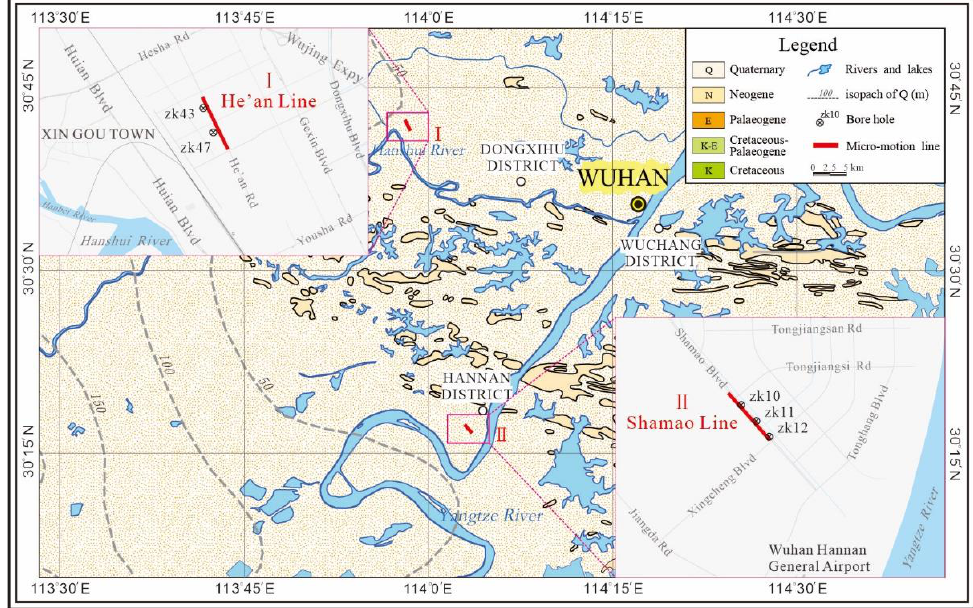
Figure 1. Location of survey lines in the study area.